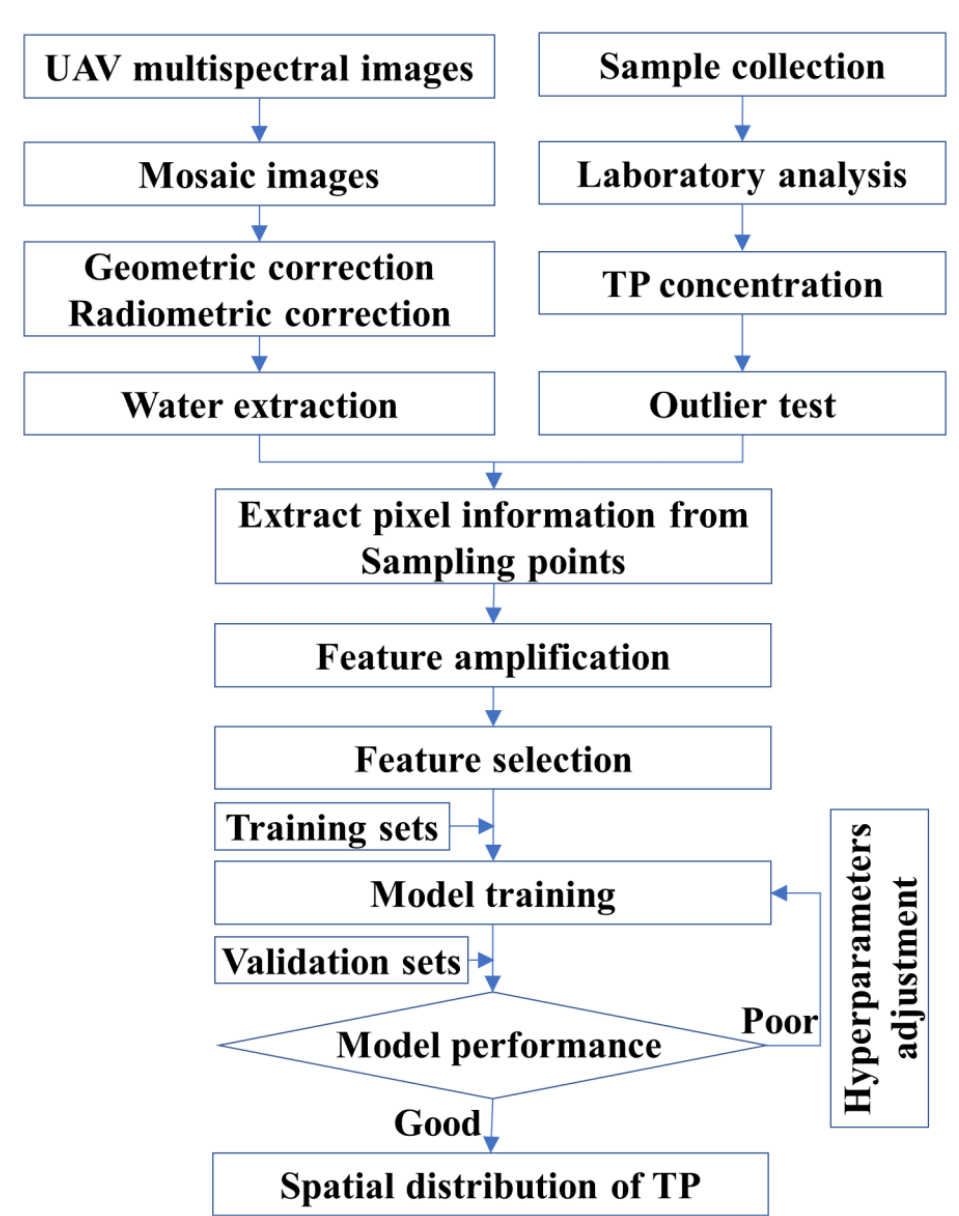
Figure 2. Flowchart of Model Development.